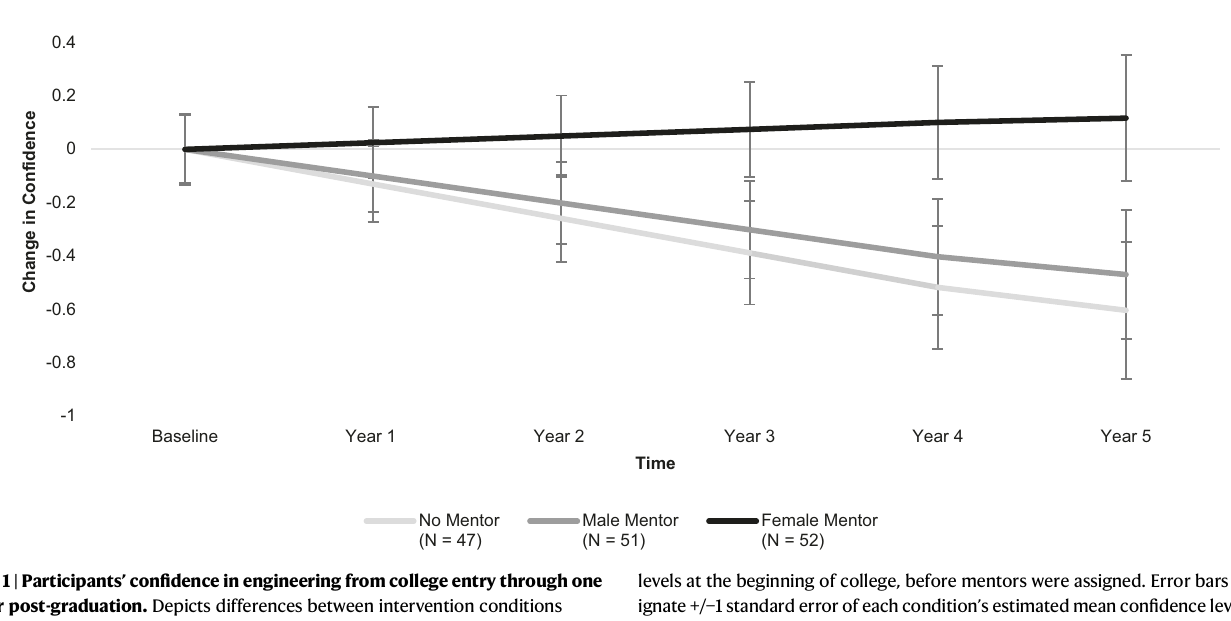
Fig.1|Participants ’ con fi denceinengineeringfromcollegeentrythroughone year post-graduation. Depicts differences between intervention conditions (no mentor, male mentor, female mentor) in participants ’ average change in con fi denceintheirengineeringabilitiesover fi veyears,relativetotheircon fi dence